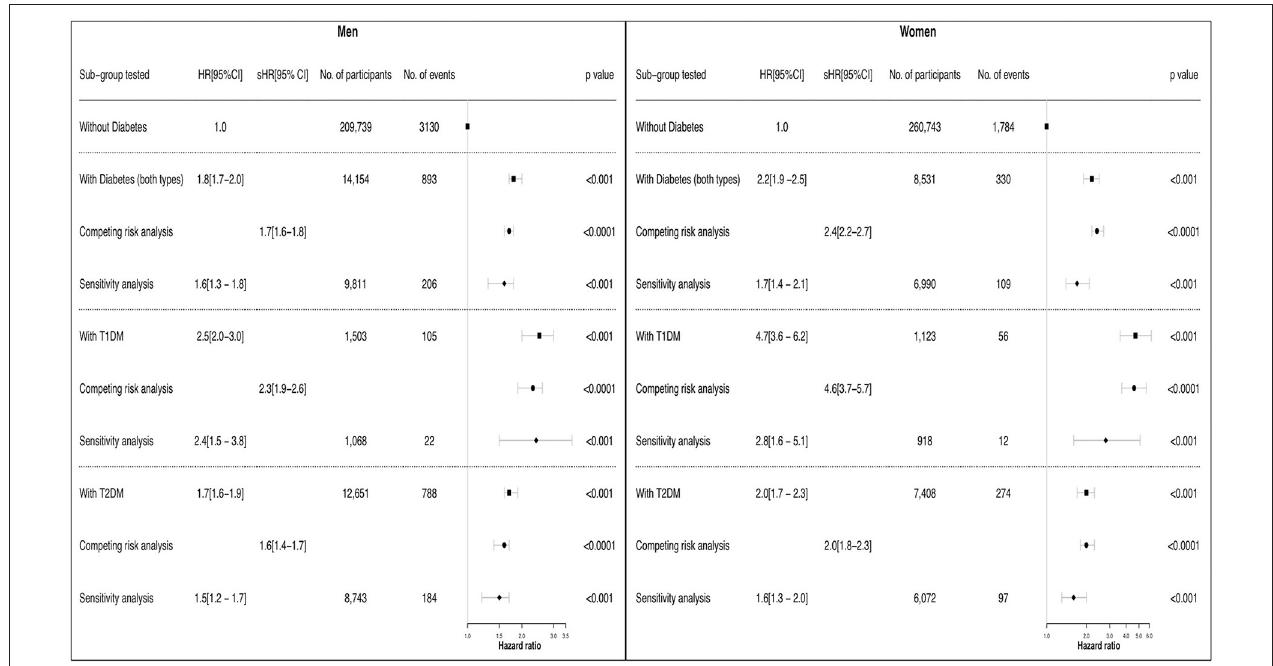
FIGURE 4 | Association between Diabetes, Gender and Incident of Heart Failure – multivariate, competitive risk and sensitivity analysis. Forest plot demonstrating risk of HF between men and women for each subset of participants with diabetes. The multivariate cox models were adjusted for age, ethnicity, hypertension, hypercholesterolaemia, smoking, BMI, alcohol status with coronary artery disease stratified. Interaction term between sex and heart failure is significant in the T1DM group ( p = 0.0001) and for the overall diabetes group ( p = 0.007). Interaction term for sex and heart failure in T2DM is p = 0.1. Competing risk confirms the trend seen in the multivariate analysis, and indicates that the increased risk in women especially with T1DM is significant enough to be above all-cause mortality. T1DM, type 1 diabetes; T2DM, type 2 diabetes; HR, hazard ratio; sHR, sub-distribution hazard